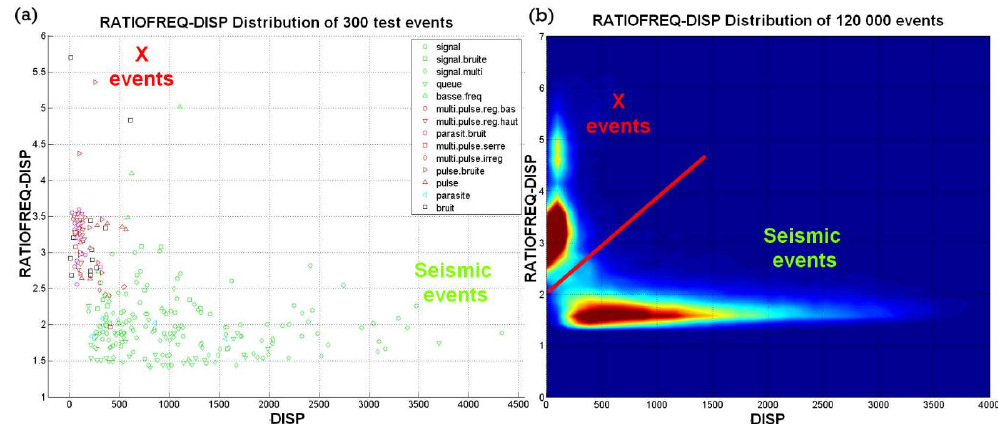
Figure 4 – Separation of ‘X’ and ‘seismic’ event families on a RATIOFREQ versus DISP crossplot (a: 3 Fig. 4. Separation of “X” and “seismic” event families on a RATIOFREQ versus DISP crossplot ( a : samples, b : set of 120000 events). samples, b: set of 120,000 events). 4